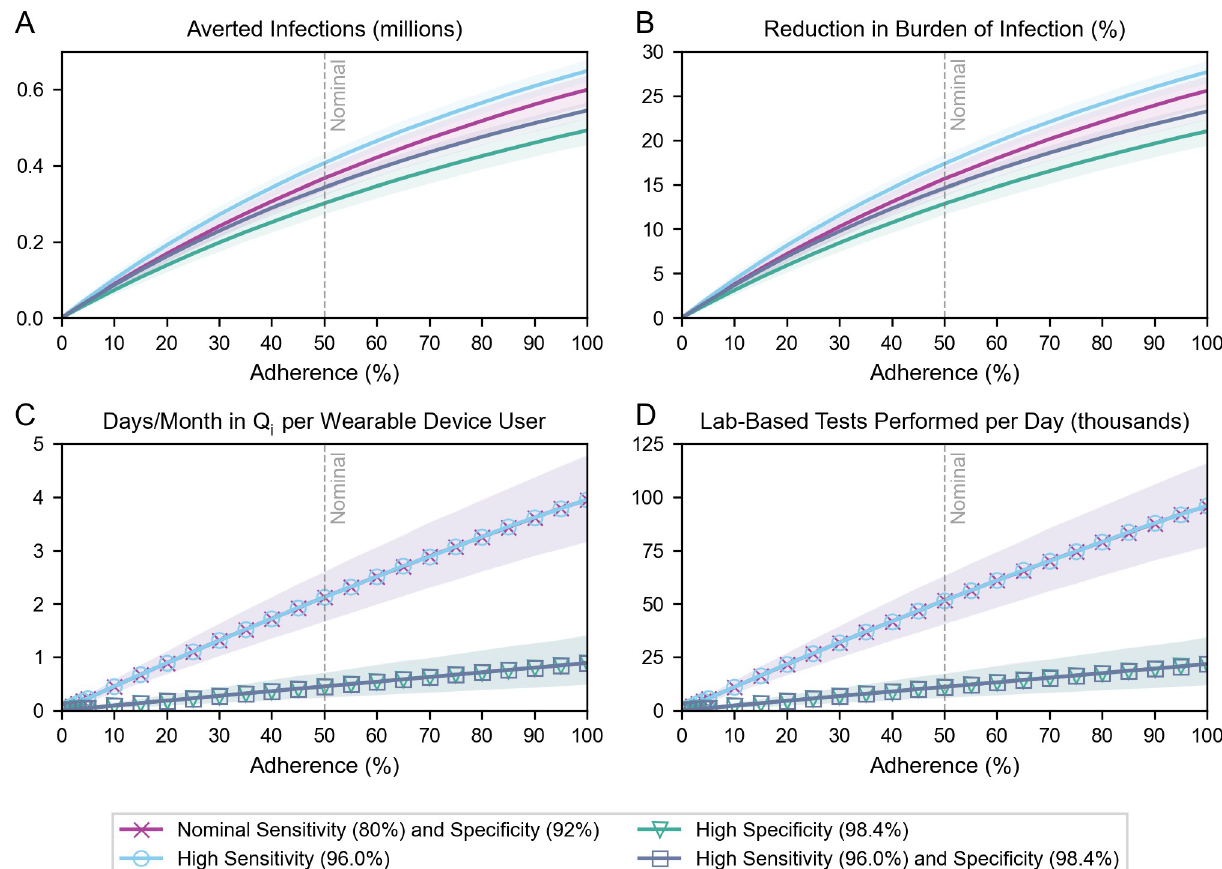
Fig 5. Impact of increasing adherence under different technology assumptions. (A) Averted infections, (B) reduction in the burden of infection, (C) days incorrectly spent in quarantine per month per user, and (D) average daily demand for lab-based tests, all over the simulation period, as a function of increasing adherence. Grey dashed lines denote nominal adherence (50%). In the “High Sensitivity” and “High Specificity” scenarios, detection specificity and sensitivity are kept at their nominal values, respectively. Symbol markers are added in (C) and (D) to distinguish overlapping curves: in these charts, the “Nominal Sensitivity and Specificity” and “High Sensitivity” curves overlap, and the “High Specificity” and “High Sensitivity and Specificity” curves overlap.